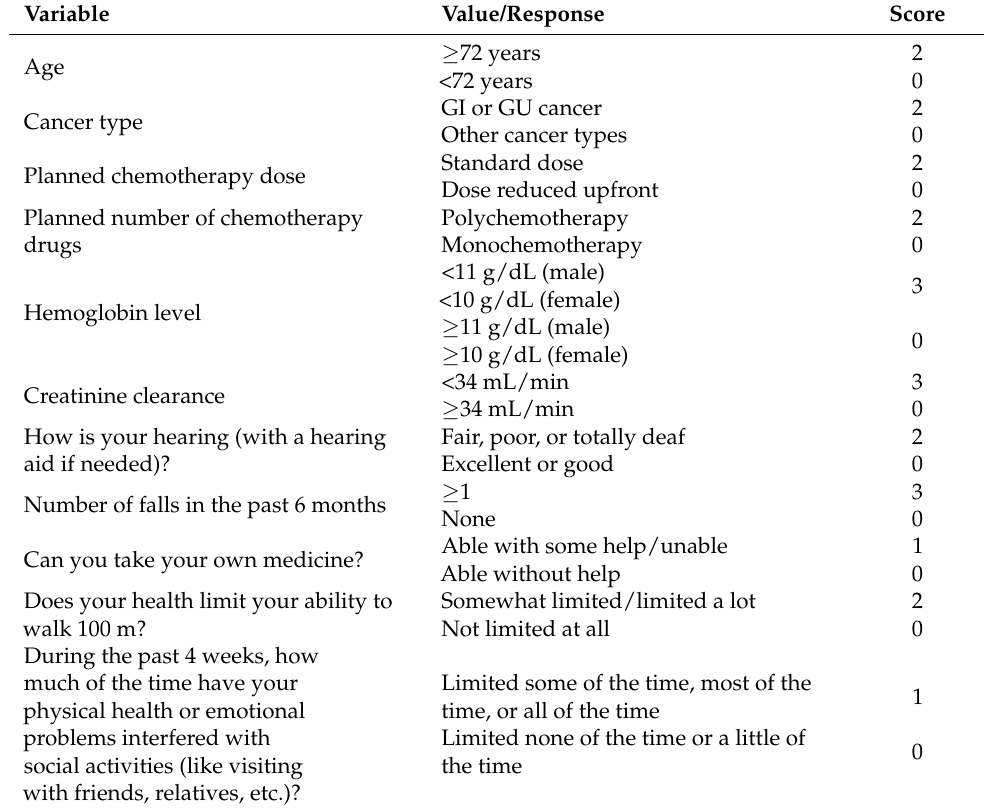
Table 1. Prediction model and scoring algorithm values used to predict chemotherapy toxicity.